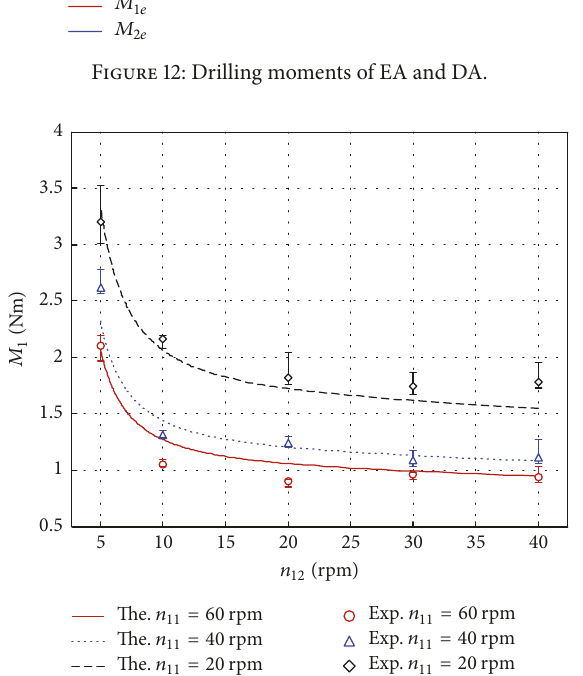
Figure 13: 𝑀 1 versus 𝑛 11 and 𝑛 12 .